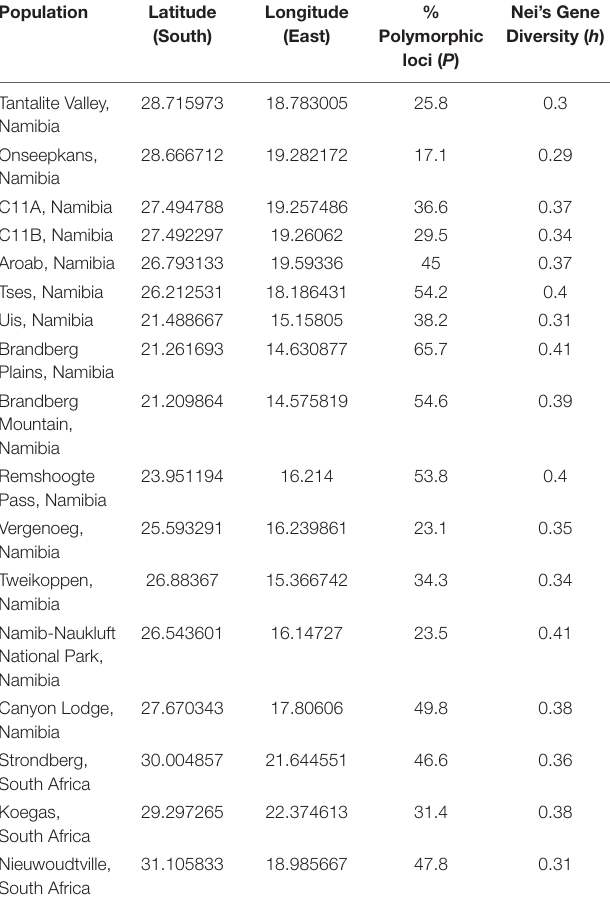
TABLE 4 | Sampling locations and estimates of genetic diversity across the range of Aloidendron dichotomum .